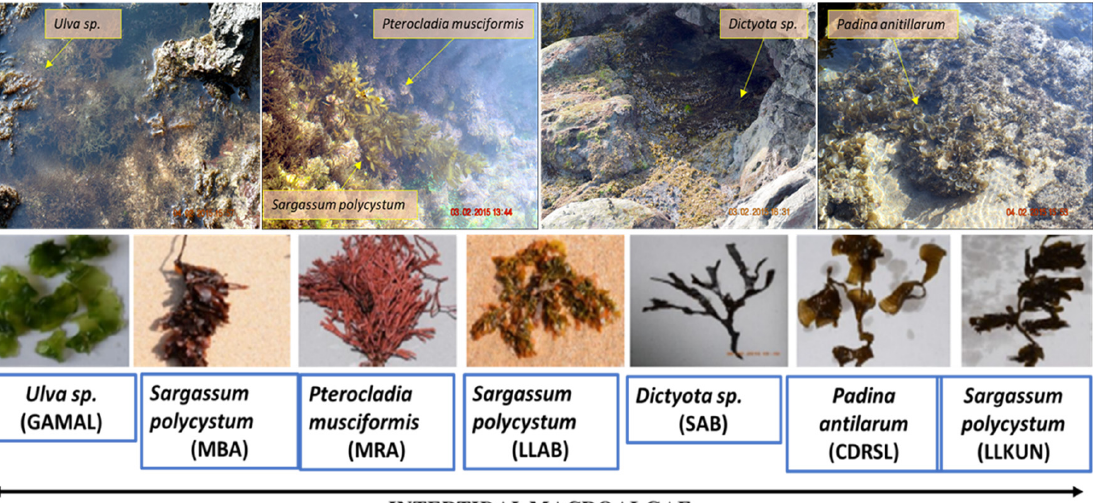
Figure 1. Photos of macroalgal samples (in-situ) and their designation code (underlined) from different locations: GAMAL (Green Algae from MALwan), MBA (Malwan Brown Algae), MRA (Malwan Red Algae), LLAB (Leaf Like sample from Anjuna Beach), SAB (Sub-tidal algae from Anjuna Beach), CDRSL (Cabo-De-Rama SampLe), LLKUN (Leaf Like sample from KUNkeshwar).